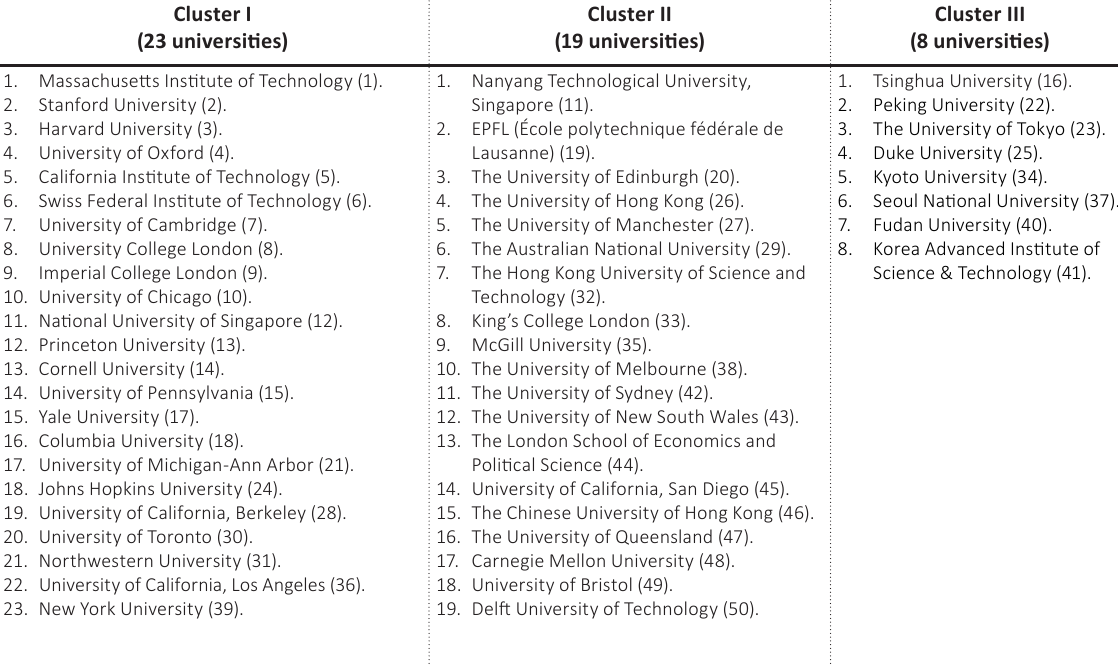
Table 2. Clustering results of the Top 50 universities by numerical values of the QS and THE calculation criteria, 2020